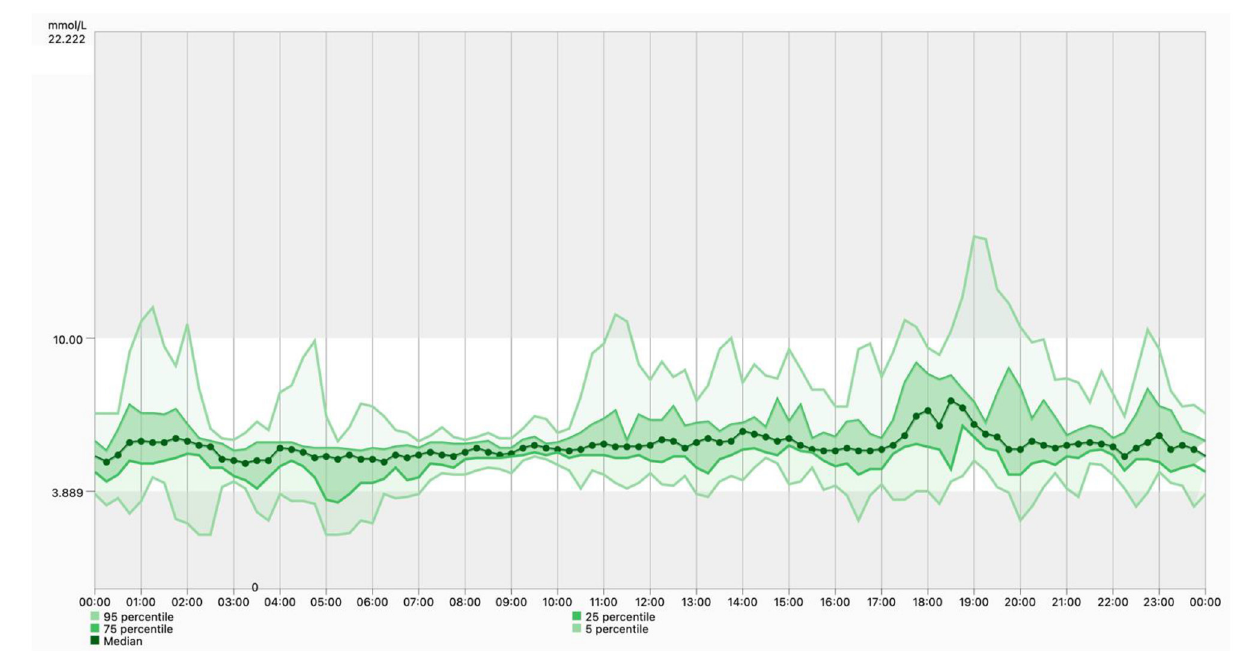
FIGURE 8 | Ambulatory glucose profile. The dashboard includes a standardized visual report once the software has sufficient numbers of days of data collection. It shows a median glucose control line; the 25th − 75th percentiles, which represents 50% of the glucose readings over the analysis time period; and the 5th − 95th percentiles, which helps identifying outliers that are contributing to the median